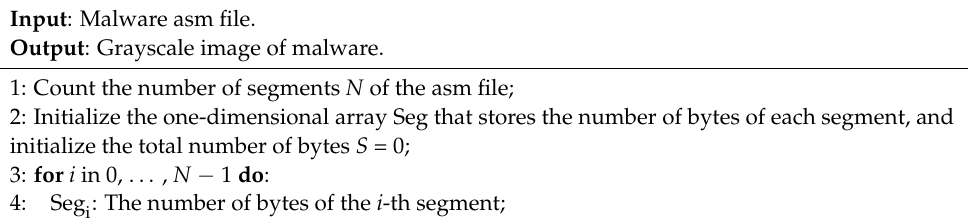
Algorithm 1: Width-Adaptive Malware Visualization